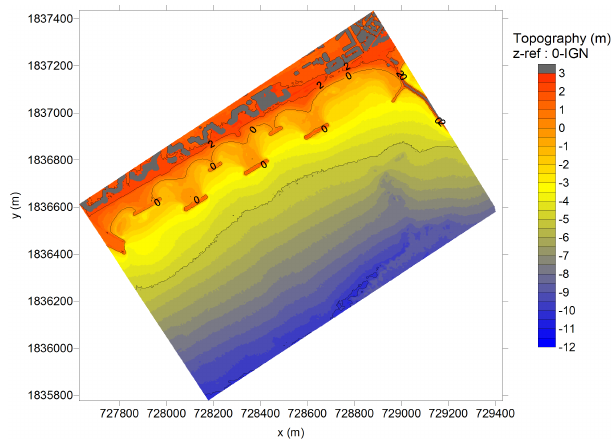
Fig. 5. 2-D domain of the SWAN implantation used for the inver-